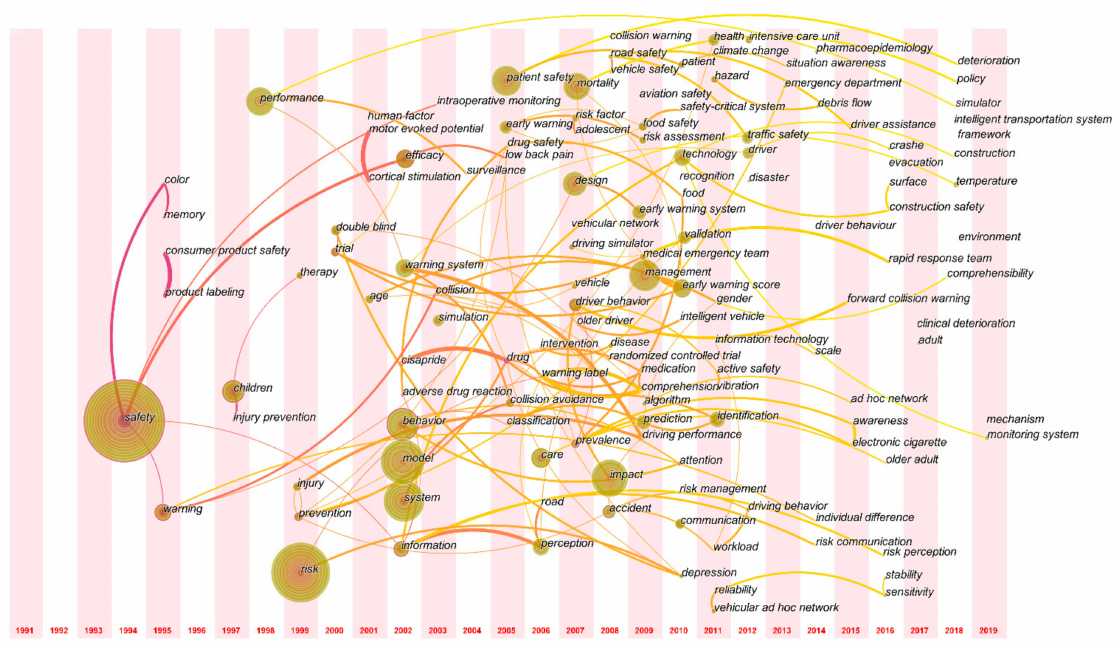
Figure 8. Time-zone view of keyword co-occurrence network of safety signs